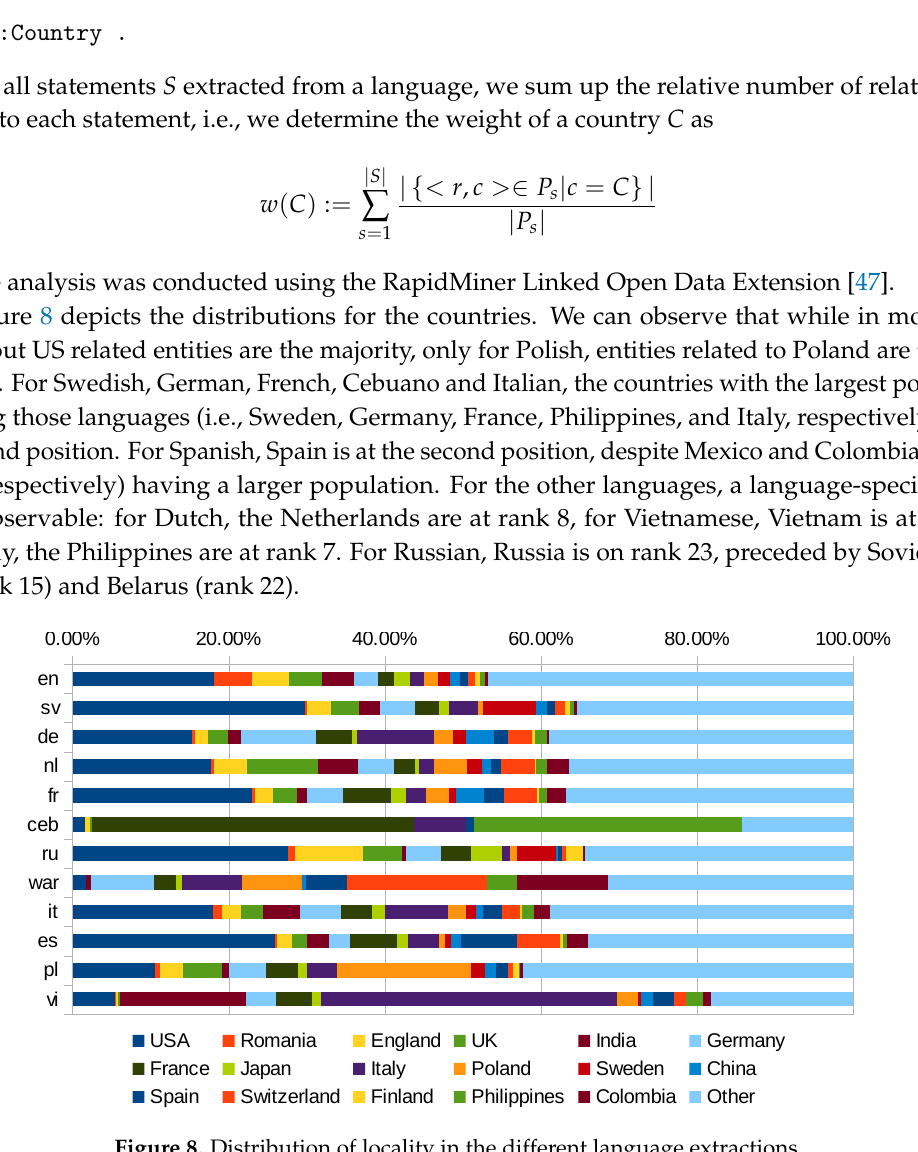
Figure 8. Distribution of locality in the different language